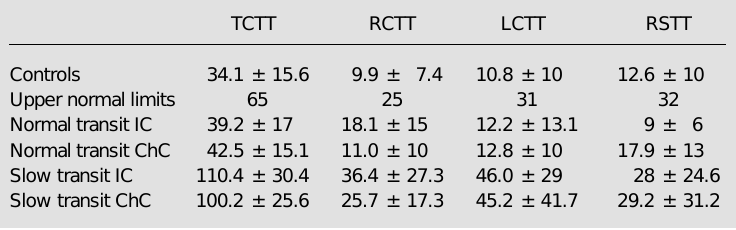
Table 2 - Total and segmental colonic transit time (CTT) in patients with idiopathic constipation (IC) and constipated patients with Chagas’ disease (ChC). Data are reported as means ± SD in hours. In patients with slow transit constipation the values of total CTT are above the upper limits of normality. TCTT: Total CTT; RCTT: right CTT; LCTT: left CTT, and RSTT: rectosigmoid transit time.